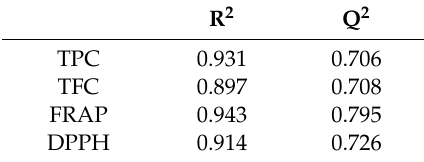
Table 6. Goodness of fit (R 2 ) and goodness of predictability (Q 2 ) coe ffi cients of statistical